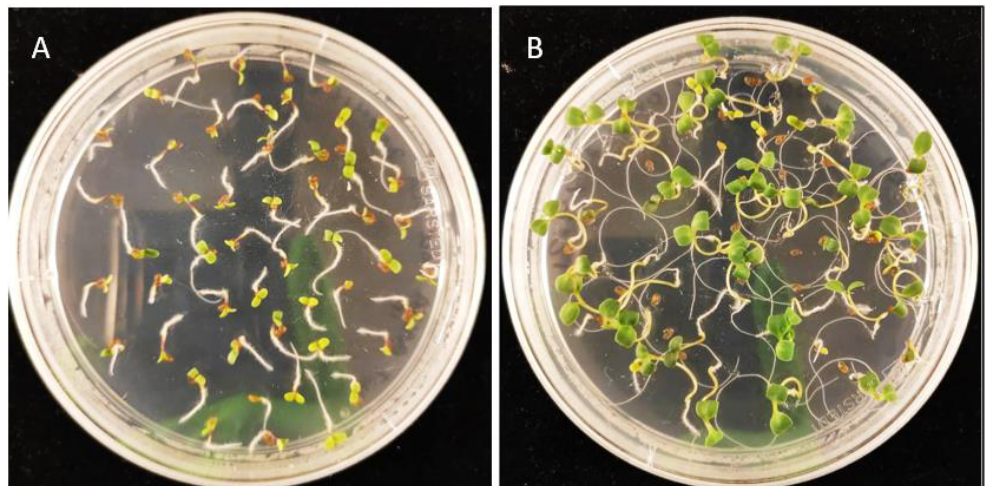
Figure 4. Selection of transgenic Camelina on MS media containing 22.5 mg/L Hygromycin. Pictures were taken after 14 days. ( A ) WT Camelina sativa ( B ) Segregating T2 generation of pH2GW7 trans- formants (hygromycin-resistant).